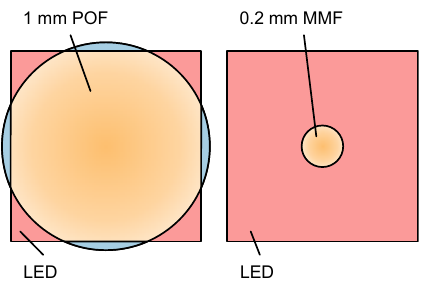
Figure 7. Graphic representation of the coupling efficiency of a 0.92 × 0.92mm 2 LED to a fiber regarding the core diameter. Left: core ∅ = 980µm. Right: core ∅ = 200µm.